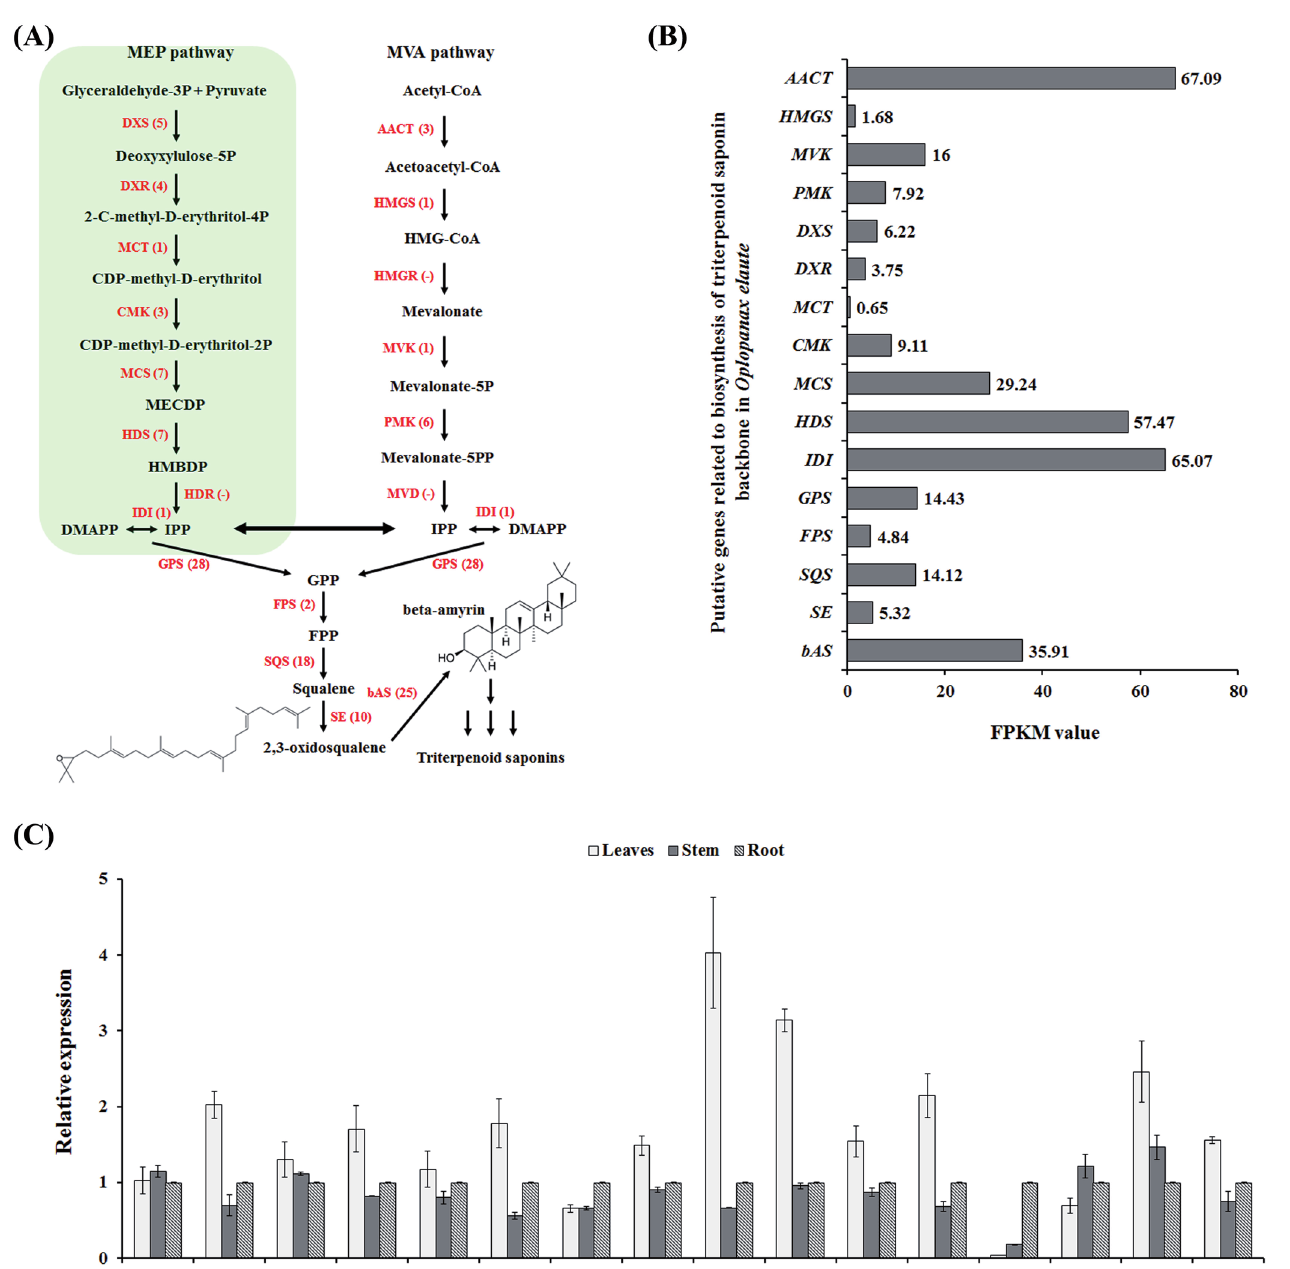
Fig. 3: Relative expression of putative genes involved in the biosynthesis of the triterpenoid saponin backbone. (A) Oplopanax elatus unigenes involved in the biosynthesis of the backbone of triterpenoid saponins. Enzyme names are abbreviated as follows: Acetyl-CoA C-acetyltransferase (AACT), Hydroxymethylglutaryl-CoA synthase (HMGS), Hydroxymethylglutaryl-CoA reductase (HMGR), Mevalonate kinase (MVK), Phosphomevalonate kinase (PMK), Diphosphomevalonate decarboxylase (MVD), 1-deoxy-D-xylulose-5-phosphate synthase (DXS), 1-deoxy-D-xylulose-5-phosphate reductoisomerase (DXR), 2-C-methyl-D-erythritol 4-phosphate cytidylyltransferase (MCT), 4-diphosphocytidyl-2-C-methyl-D-erythritol kinase (CMK), 2-C-methyl-D-erythritol 2,4-cyclodiphosphate synthase (MCS), (E)-4-hydroxy-3-methylbut-2-enyl-diphosphate synthase (HDS), 4-hydroxy- 3-methylbut-2-enyl diphosphate reductase (HDR), Isopentenyl-diphosphate delta-isomerase (IDI), Geranyl pyrophosphate synthase (GPS), Farnesyl diphosphate synthase (FPS), Squalene synthase (SQS), squalene monooxygenase (SE), and beta-amyrin synthase (bAS). The red number in bracket following each gene name indicates the number of corresponding unigenes. (B) FPKM values of 16 selected genes involved in the biosynthesis of the triterpenoid saponin backbone. (C) Expression of selected genes in different organs. The expression of each gene in different organs was normalized to its expression in root. Data represent the means ± SE of three biological